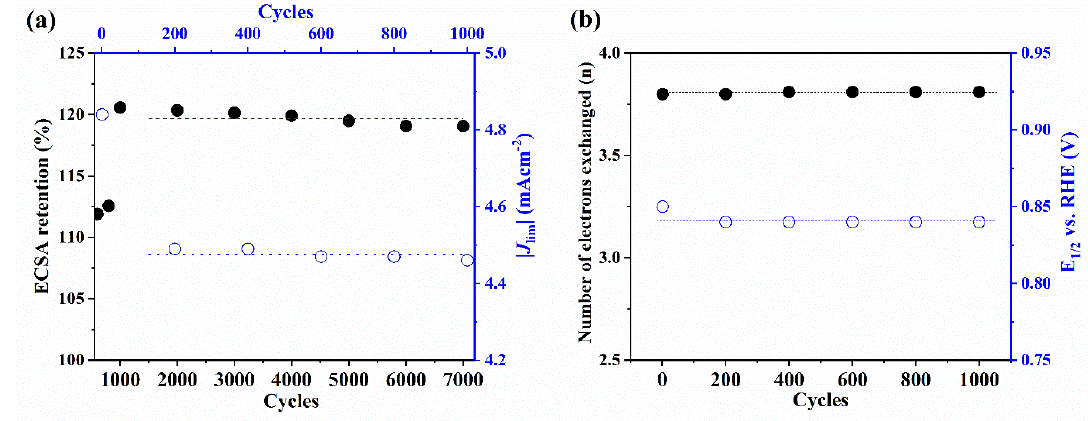
Figure 3. Durability tests of Fe-N-C catalyst: ( a ) ECSA retention (black circles) and J lim values over 7000 cycles (empty blue circles); ( b ) number of electrons exchanged (black circles) and E 1/2 over 1000 cycles (empty blue circles).